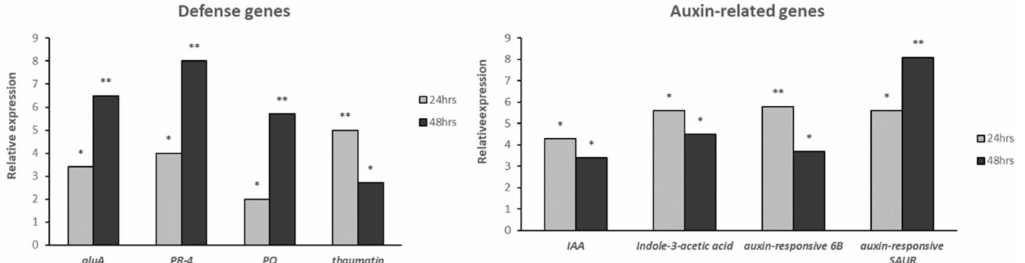
Figure 5. Expression levels of auxin and defense proteins encoding genes in the roots of cucumber plants treated with Bacillus subtilis MBI600, 24 and 48 h post-application. Gene expression levels were normalized by respective expression before the BCA application (time point 0 h). The cDNA samples were normalized using the endogenous cox gene and the expression levels were calculated using the 2 − ∆∆ Ct method [26]. Asterisks on the columns indicate statistically significant differences according to Tukey’s test ( p <